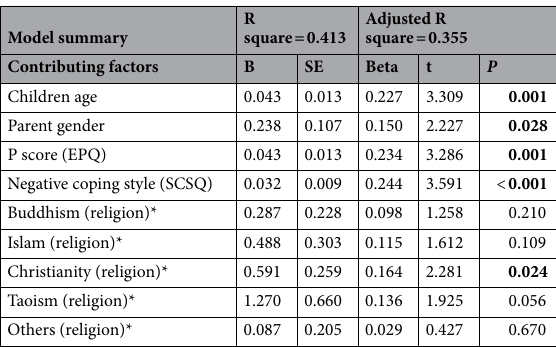
Table 3. Multiple linear regression model for contributing factors of total average score (SCL-90). Significant values are in [bold]. *The dummy variable of religion; the reference was none (religion).